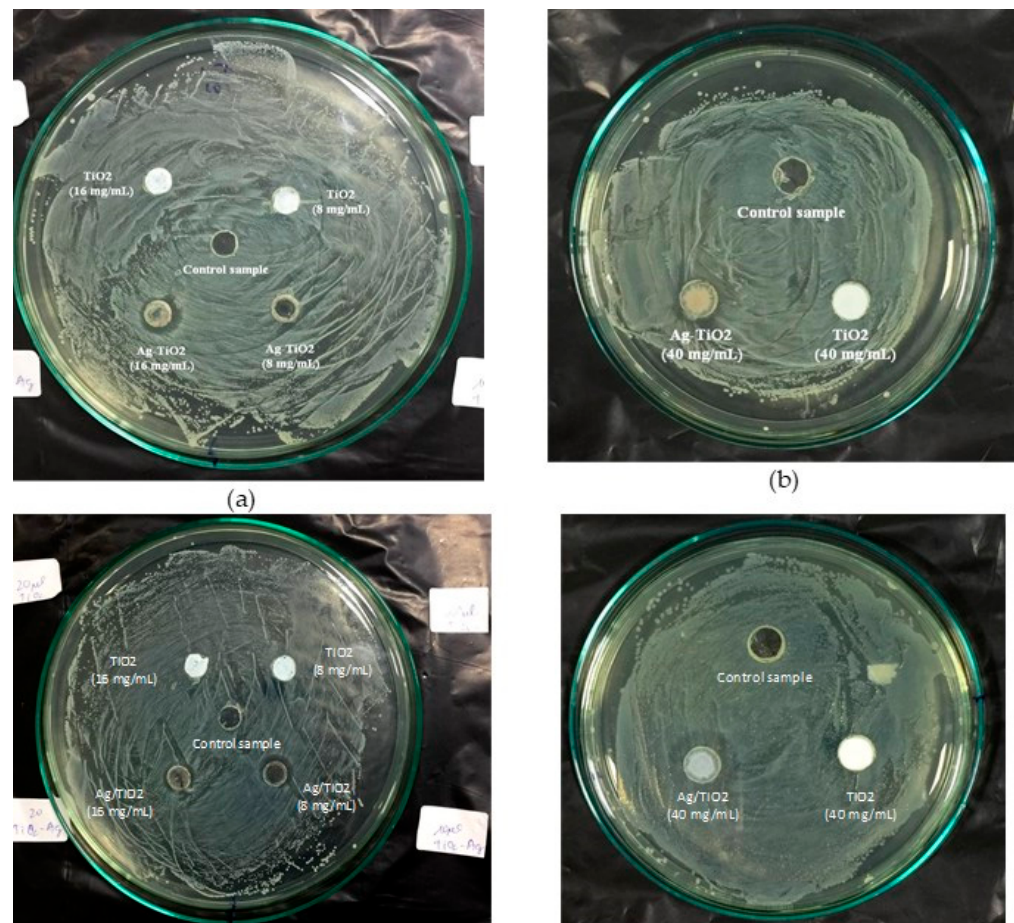
Figure 7. Photographs of antibacterial test against Staphylococcus aureus bacteria (agar-well diffusion method) for pure TiO 2 and Ag-loaded TiO 2 nanoparticles: ( a ) and ( b ): without light irradiation; ( c ) and ( d ): under light irradiation. Concentrations of AgNPs used are 8, 16, and 40 mg/mL.